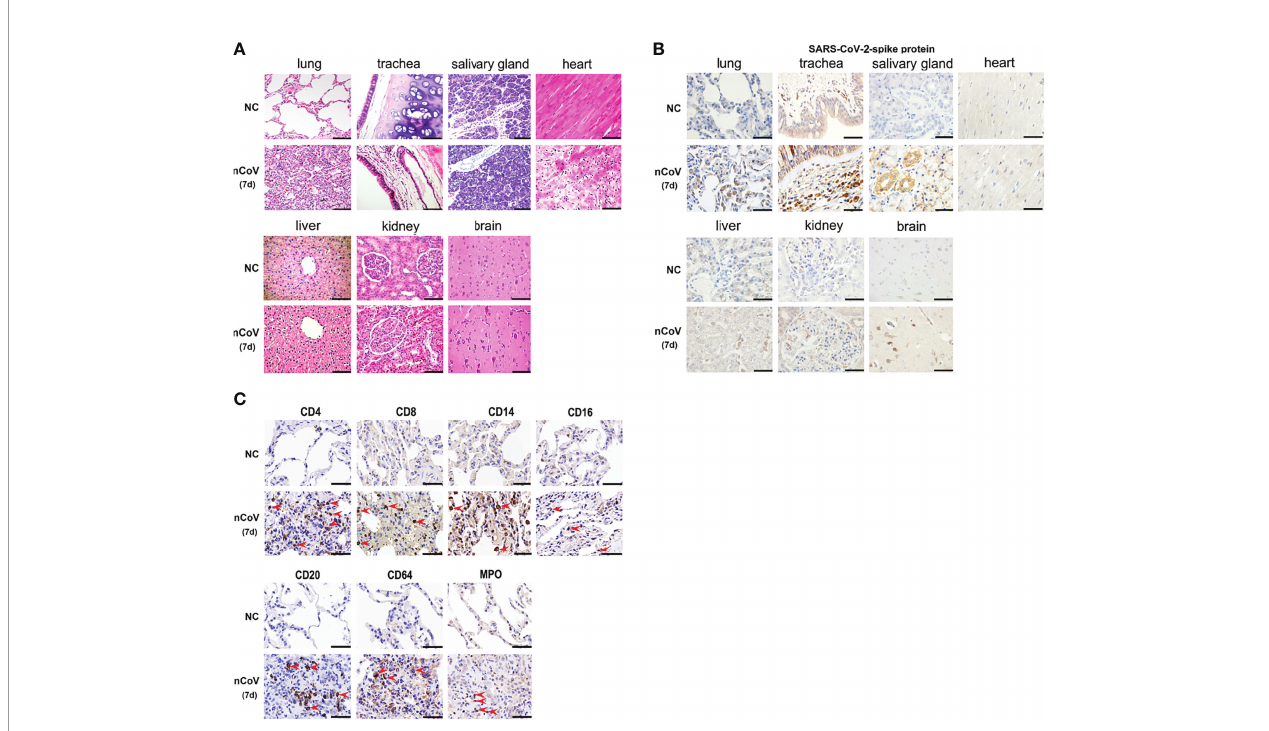
FIGURE 5 | Pathological evaluation, viral distribution and host response in tissues of COVID-19 CMs. (A) After necropsy, different tissue samples were cut and fi xed in 10% neutral buffered formalin for H&E staining, followed by microscopic inspection. (B) SARS-CoV-2 – Spike antibody was used to evaluate the viral load and distribution in different tissues. (C) In fi ltration of immune cells was examined in the lung tissues. The red arrowheads indicate corresponding positive cells in the pulmonary airspace. Scale bar=100 m m. NC, negative control; nCoV, SARS-CoV-2; 7d, 7 days post infection; CMs, cynomolgus